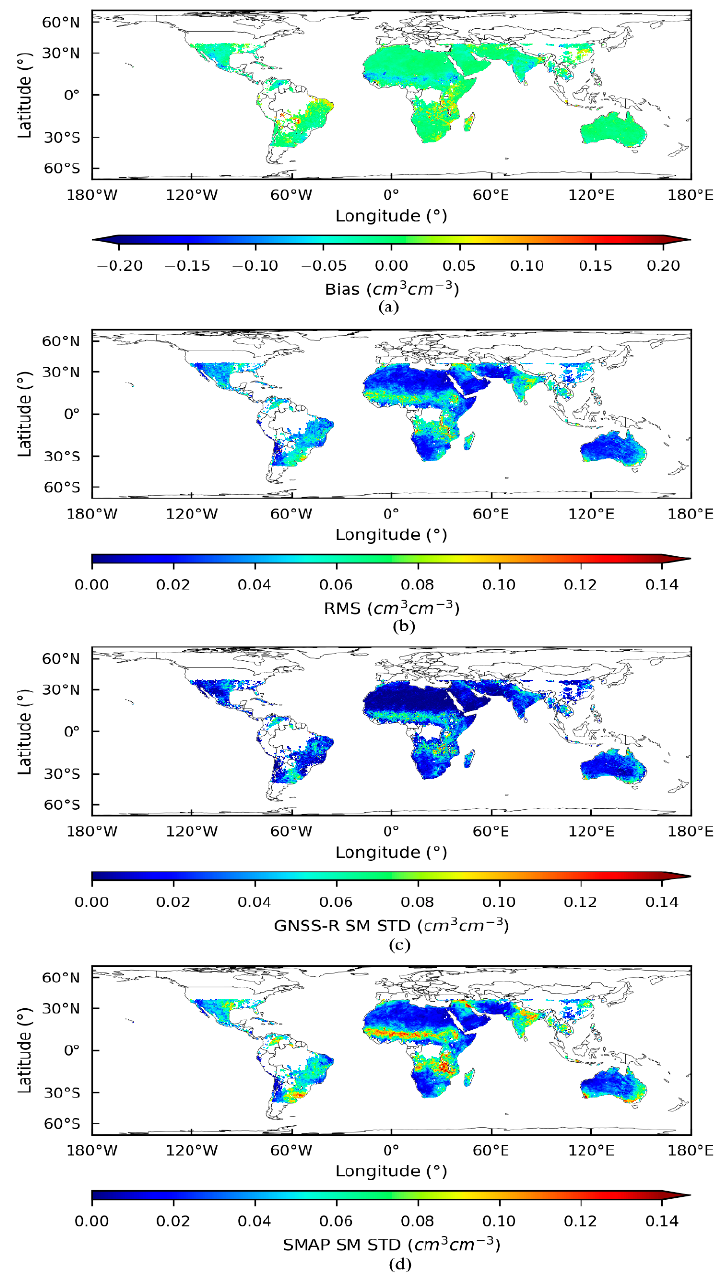
Figure 7. Bias ( a ) and RMS ( b ) of GNSS-R retrieved SSM, STD of SMAP SSM ( c ) and GNSS-R inversed SSM ( d ).